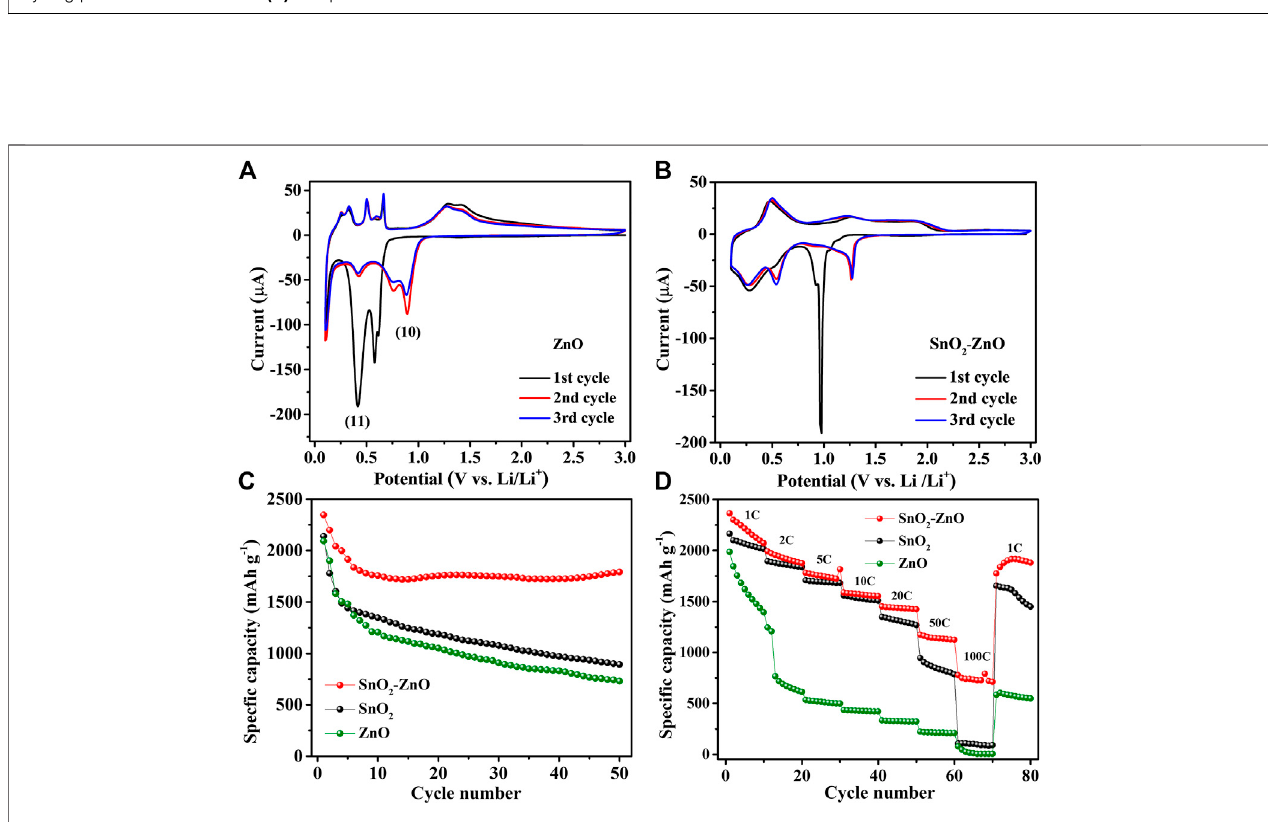
FIGURE6| CVcurves of (A) alloying-typeZnOand (B) SnO 2 – ZnOcompositeelectrodes.ThecomparisonofSnO 2 ,ZnOandSnO 2 – ZnOcompositeelectrode: (C) cycling performance at 1 C and (D) rate performance from 1 to 100 C.